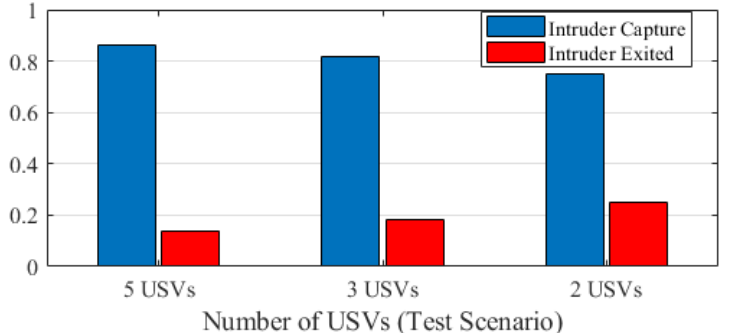
Figure 9. Success rate of USVs when intruder and USV speeds are same (USV speed = 5 m · s − 1 , USV detection radius = 200 m, and intruder speed = 5 m · s − 1